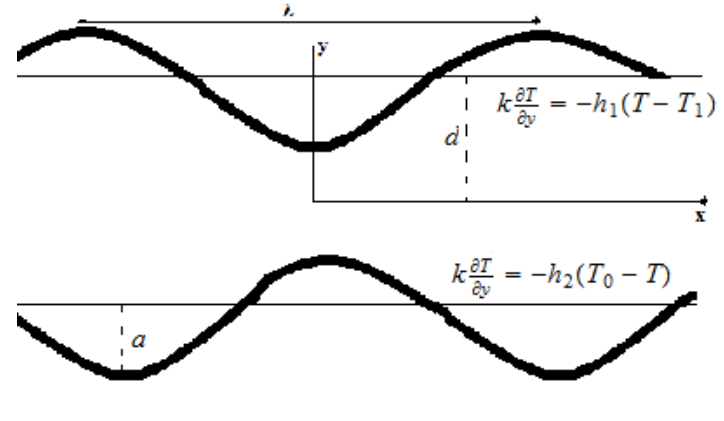
Figure 1. Schematic representation of the